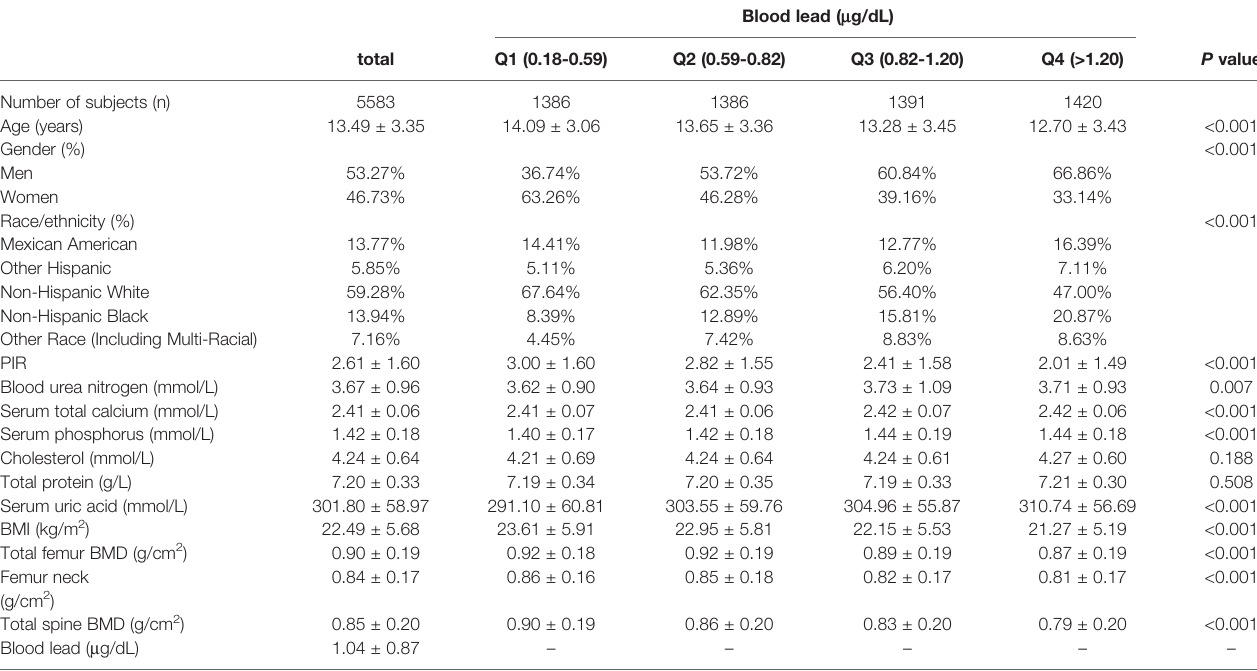
TABLE 1 | Characteristics of the study population based on BLL